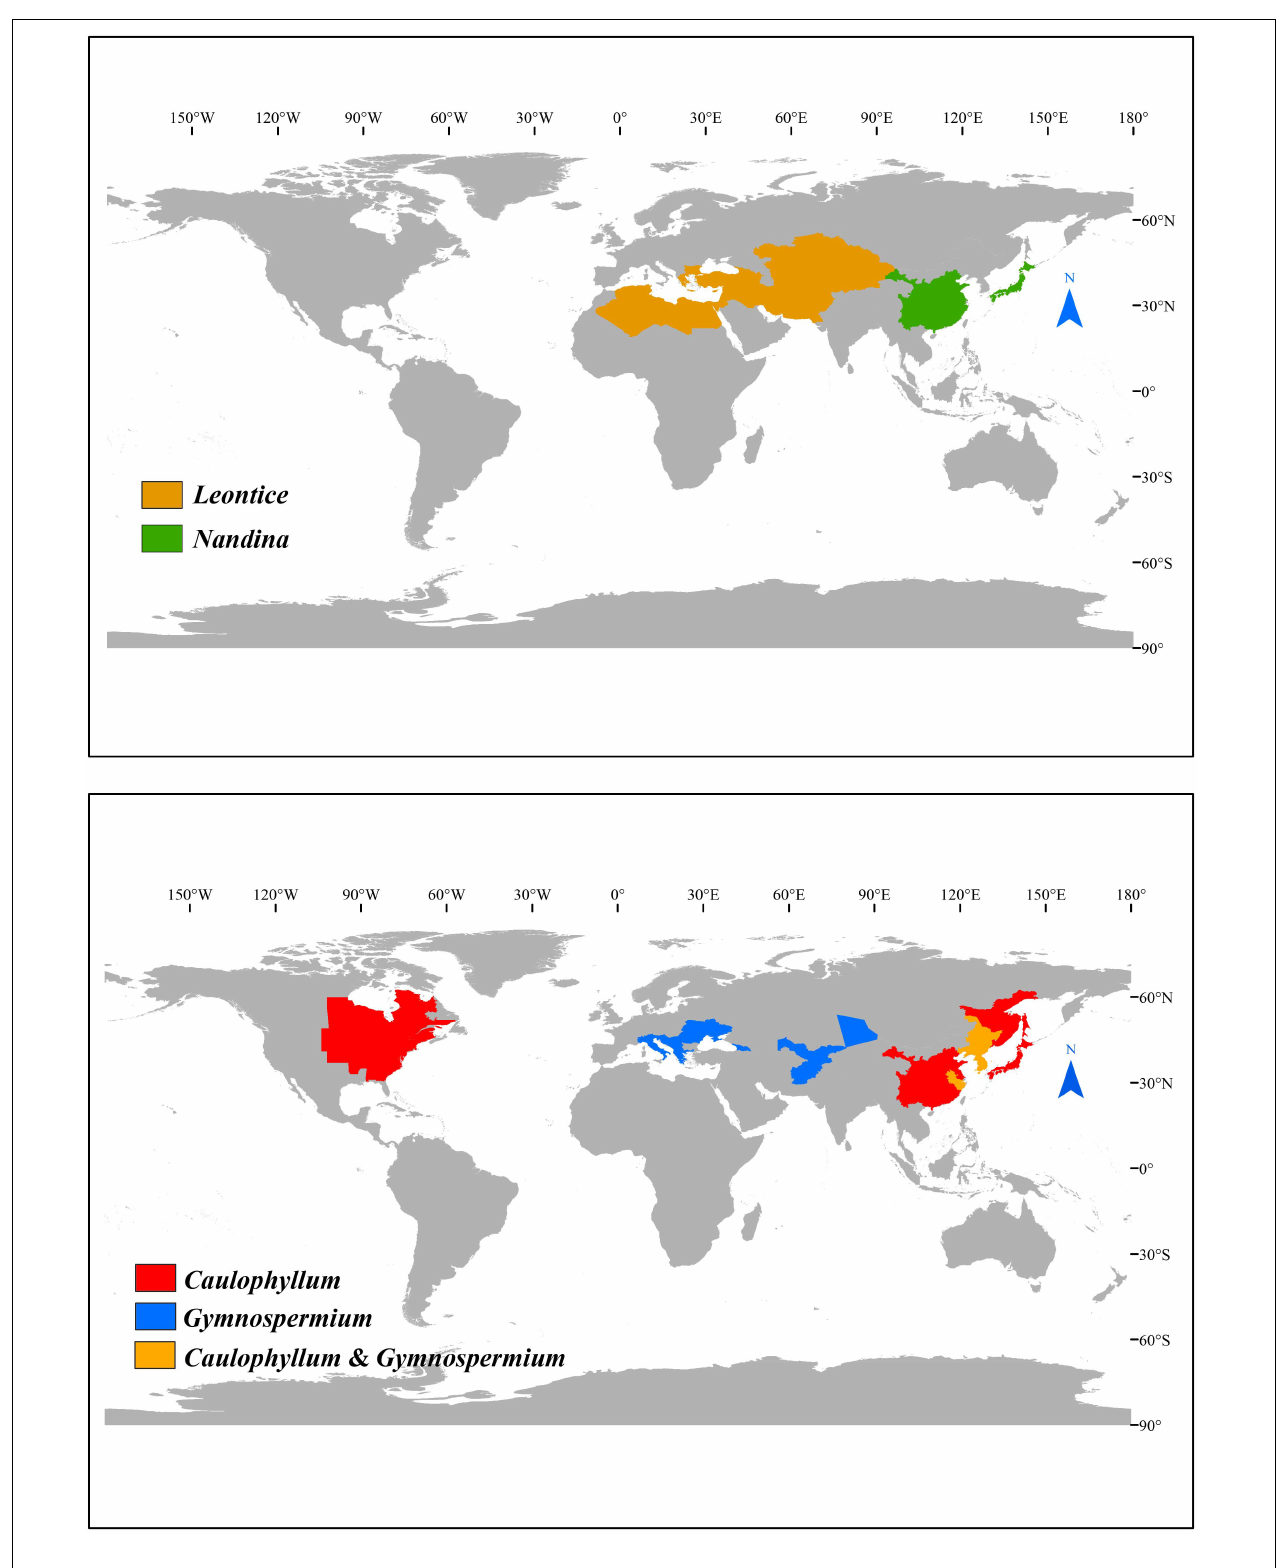
FIGURE 1 | The distribution of Nandinoideae genera.